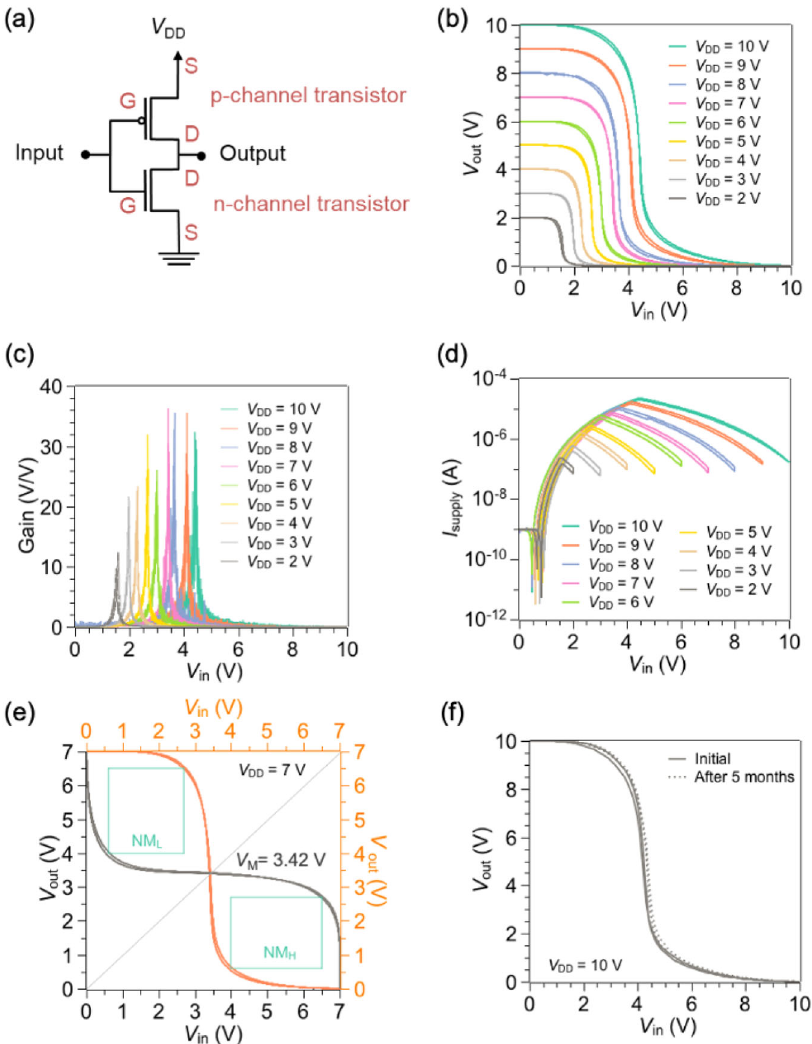
Fig. 3 Electrical performance of the hybrid complementary inverter. a Schematic diagram. b Voltage transfer curves (VTCs), c voltage gains, and d static current at V DD = 2 – 10 V. e VTCs at V DD = 7 V with noise margins represented by the green rectangles. V M = 3.42 V, NM H = 2.5 V, and NM L = 1.9 V. f VTCs before and after exposure to air for 5 months ( V DD = 10